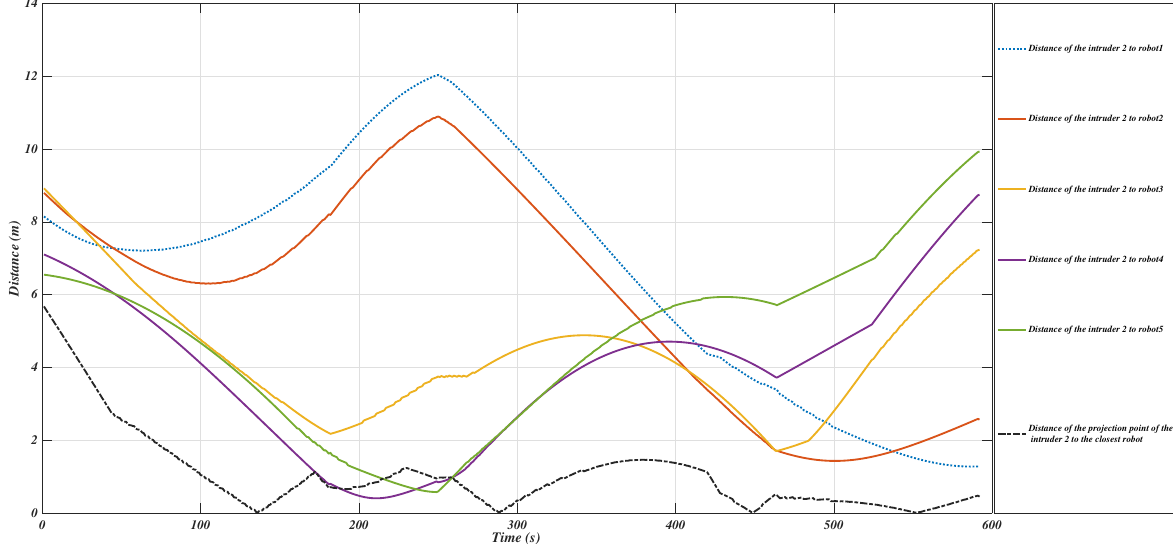
Figure 8. The evolution of the y -coordinates of the intruder2 and the USVs in segment S